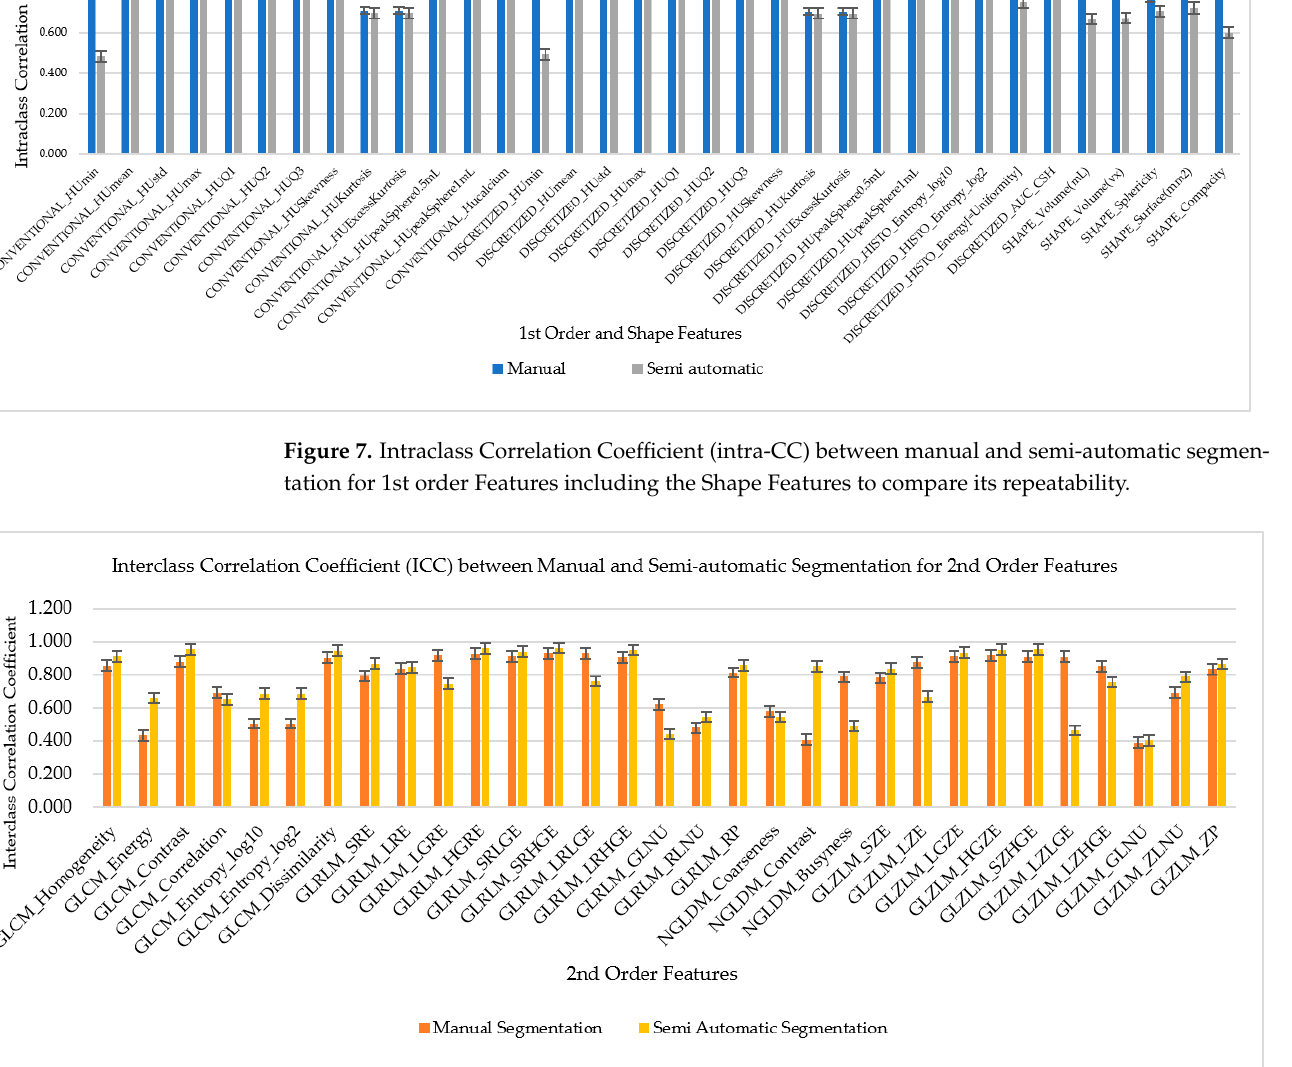
Figure 8. Interclass Correlation Coefficient (inter-CC) between manual and semi-automatic segmen- tation for 2nd order features to compare its reproducibility.